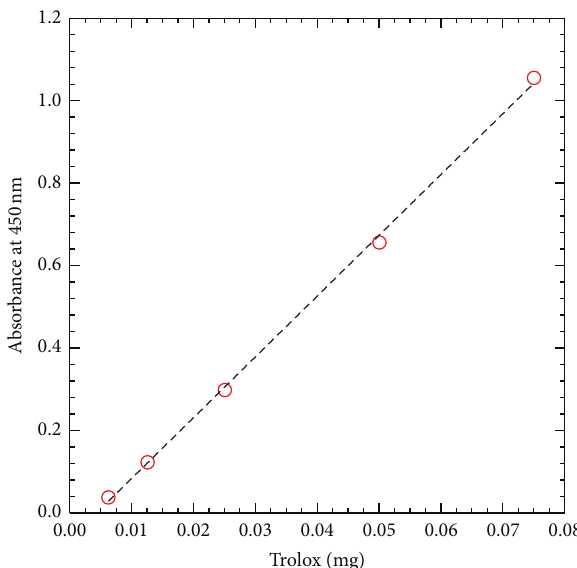
Figure 1: Variation of absorbance at 450 nm of trolox solution with its trolox content. Dashed line represents the best linear fit to data points.